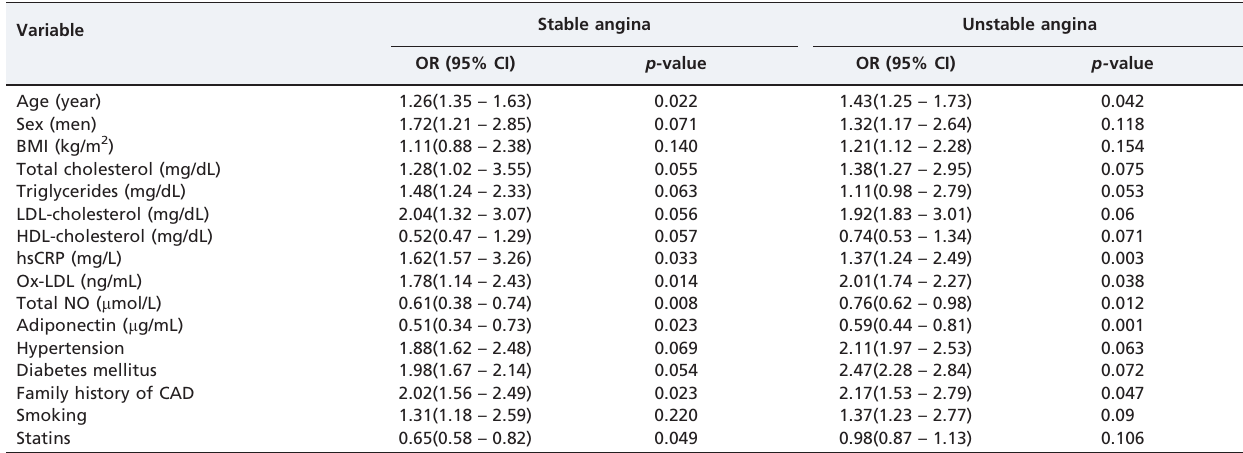
Table 3 - Multiple logistic regression analysis of independent predictors for stable and unstable angina.